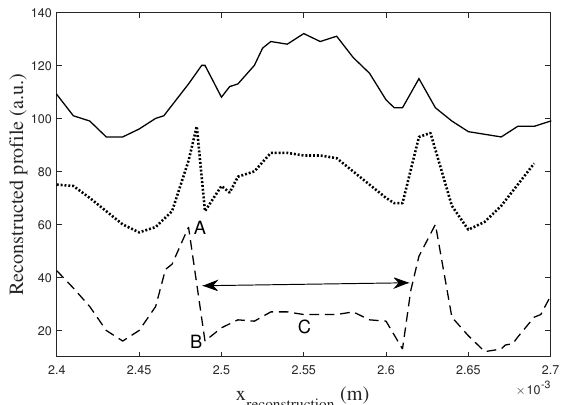
Figure 6. Transverse intensity profiles of the reconstructed phase objects [ I ( x, y )]( x , y ) | ) when ϕ = 0 . 25 π (solid line), ϕ = 0 . 5 π (dotted line) ( | F α α α opt x ,α opt y and ϕ = π (dashed